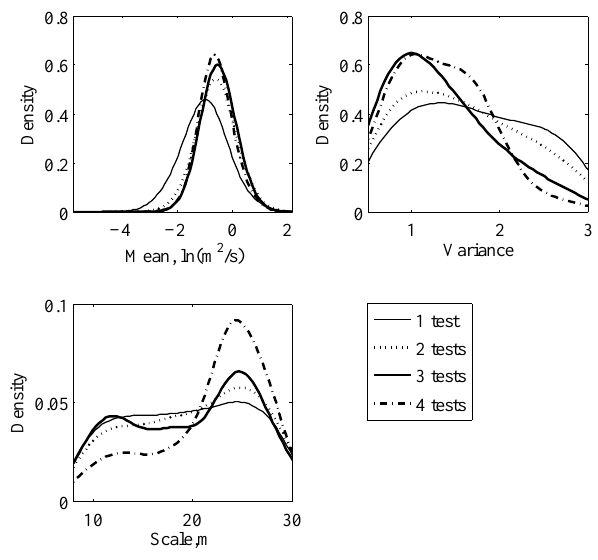
Fig. 7. Marginal posterior distributions of the structural parameters (mean, variance and scale) for the Hanford IFRC site